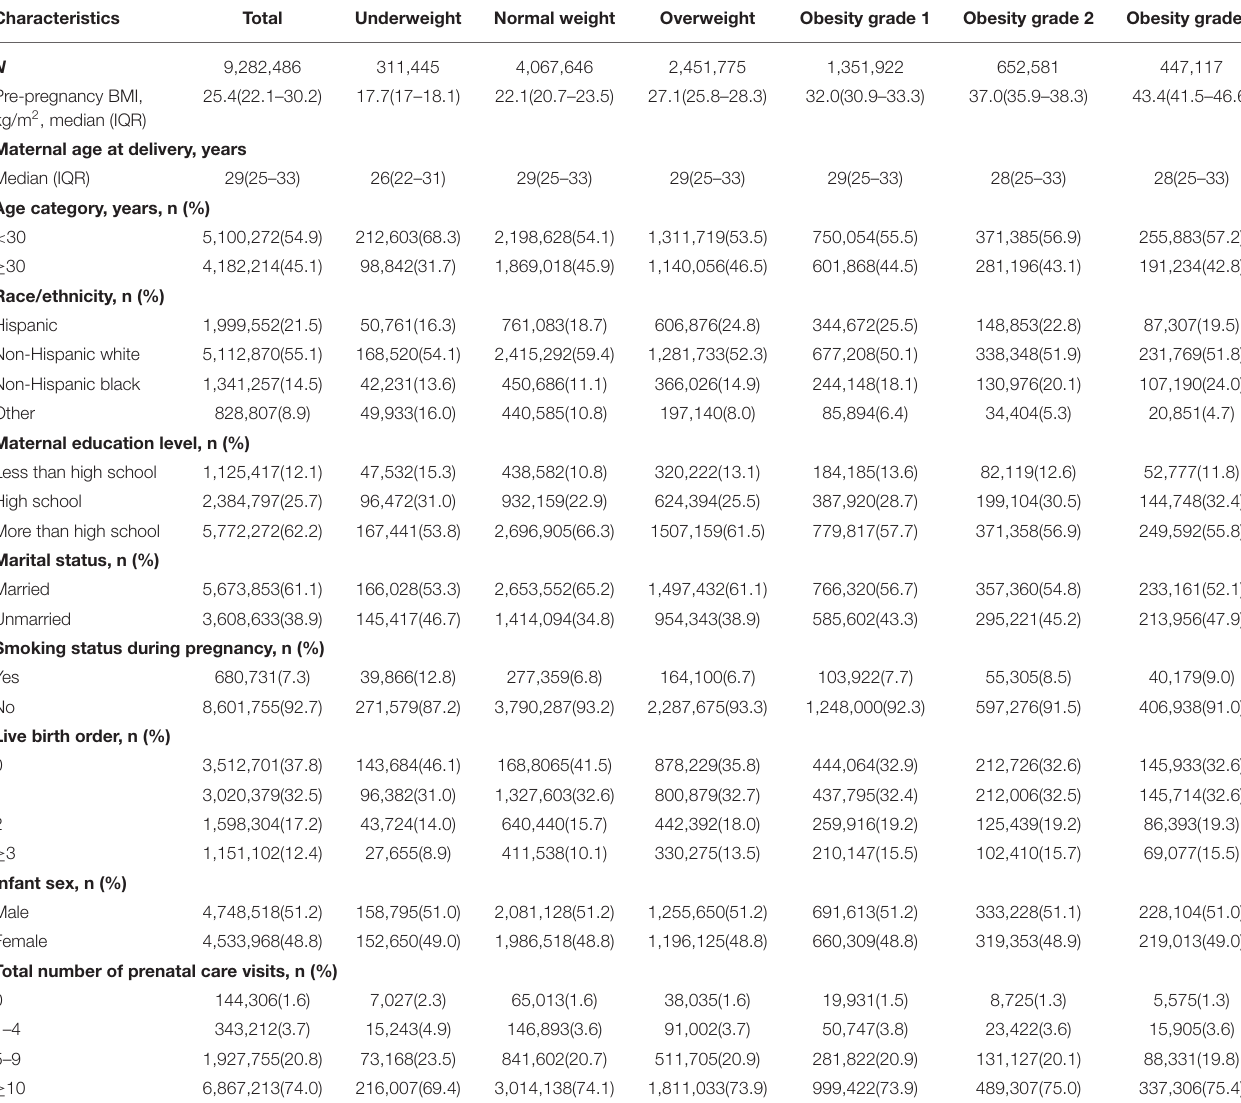
TABLE 1 | Characteristics of the study population by maternal prepregnancy BMI categories.